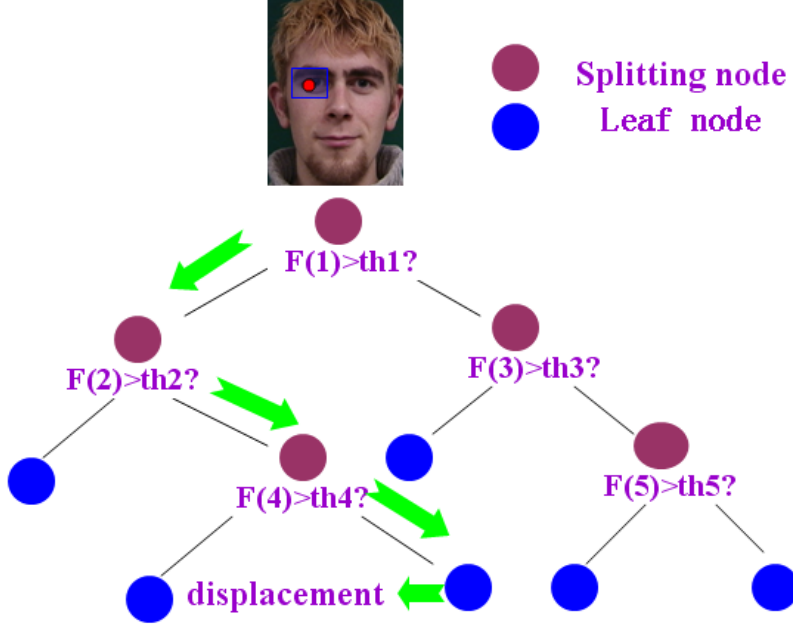
Figure 11. The landmark position update based on the random regression forests.